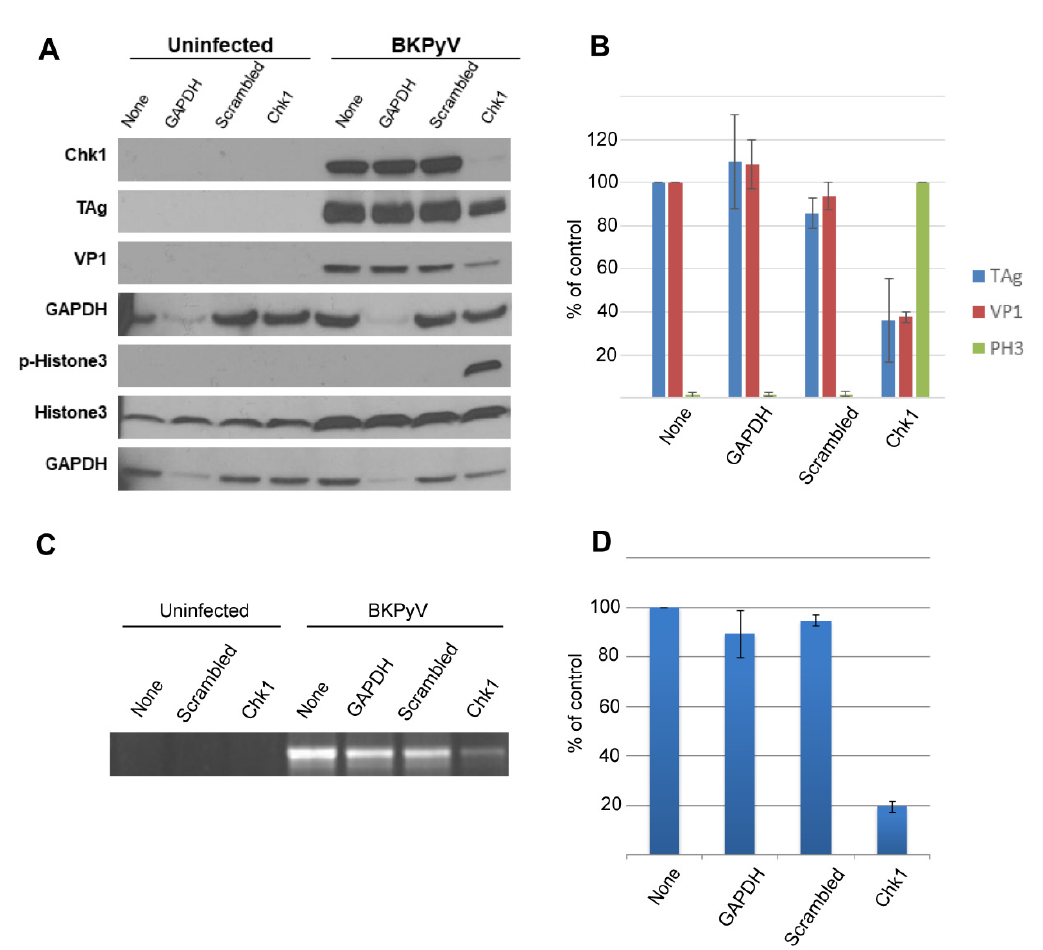
Figure 8. Chk1 knockdown decreases BKPyV proteins and DNA. Confluent RPTECs were made quiescent by removal of growth factors for 2 days. Cells were then transfected with 5 nM Chk1, GAPDH, negative silencer (scrambled), or no (None) siRNA complexes for 24 h. Removal of siRNA complexes was followed by infection with BKPyV Gardner at MOI = 10 for 1.5 h. ( A ) Cells were harvested at 3 dpi by lysis in sample buffer and subjected to immunoblot analysis with the indicated antibodies. ( B ) Protein levels of TAg and VP1 are presented as percent of the untransfected control (None). Levels of pH3-Ser10 (PH3) are relative to the BKPyV-infected, Chk1 knockdown sample; n = 3, error bars indicate standard error of the mean. ( C ) BKPyV DNA was isolated from trypsinized cells at 3 dpi and resolved by agarose gel electrophoresis. ( D ) Gels were imaged and ethidium bromide-stained bands were quantified using ImageJ; n = 3, error bars indicate standard error of the mean.